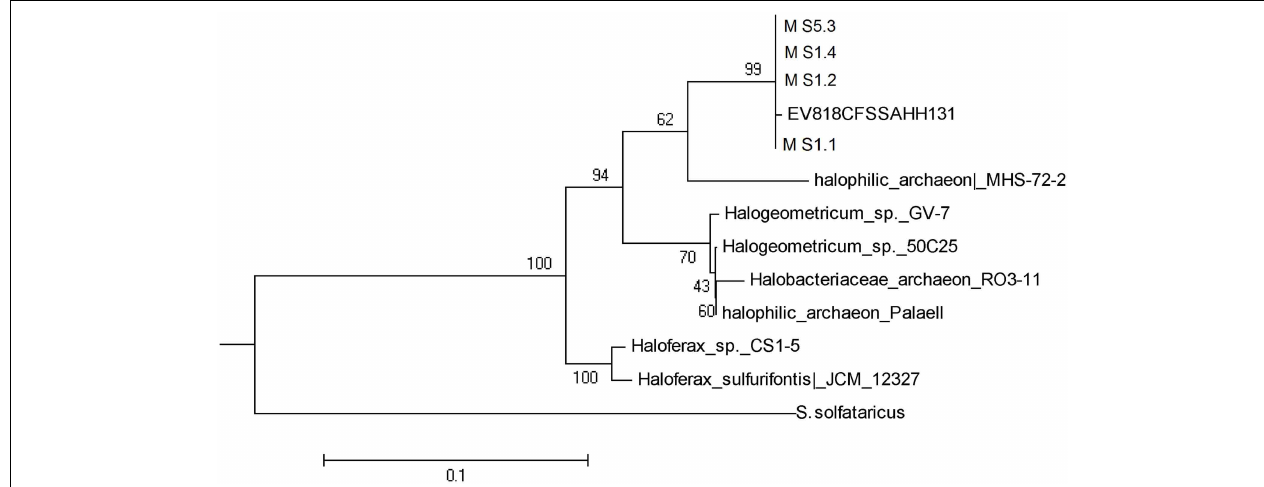
FIGURE 1 | Phylogenetic tree of the Archaea extracted from the salt